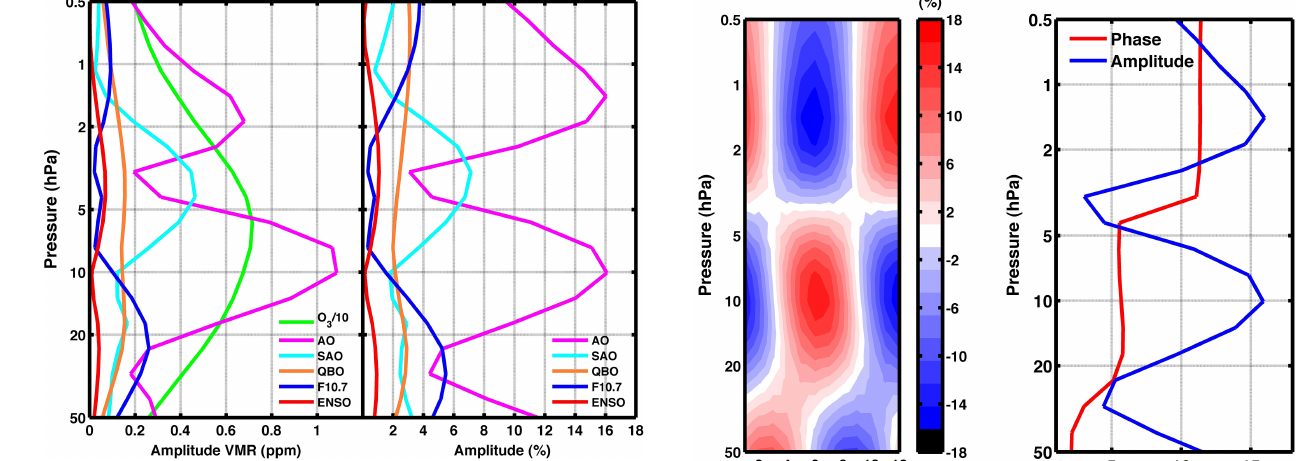
Figure 2. Amplitudes of the natural oscillations in stratospheric ozone derived by multilinear regression from the GROMOS obser- vations at Bern (1997–2015). The ozone mean profile divided by 10 is shown by the green line.